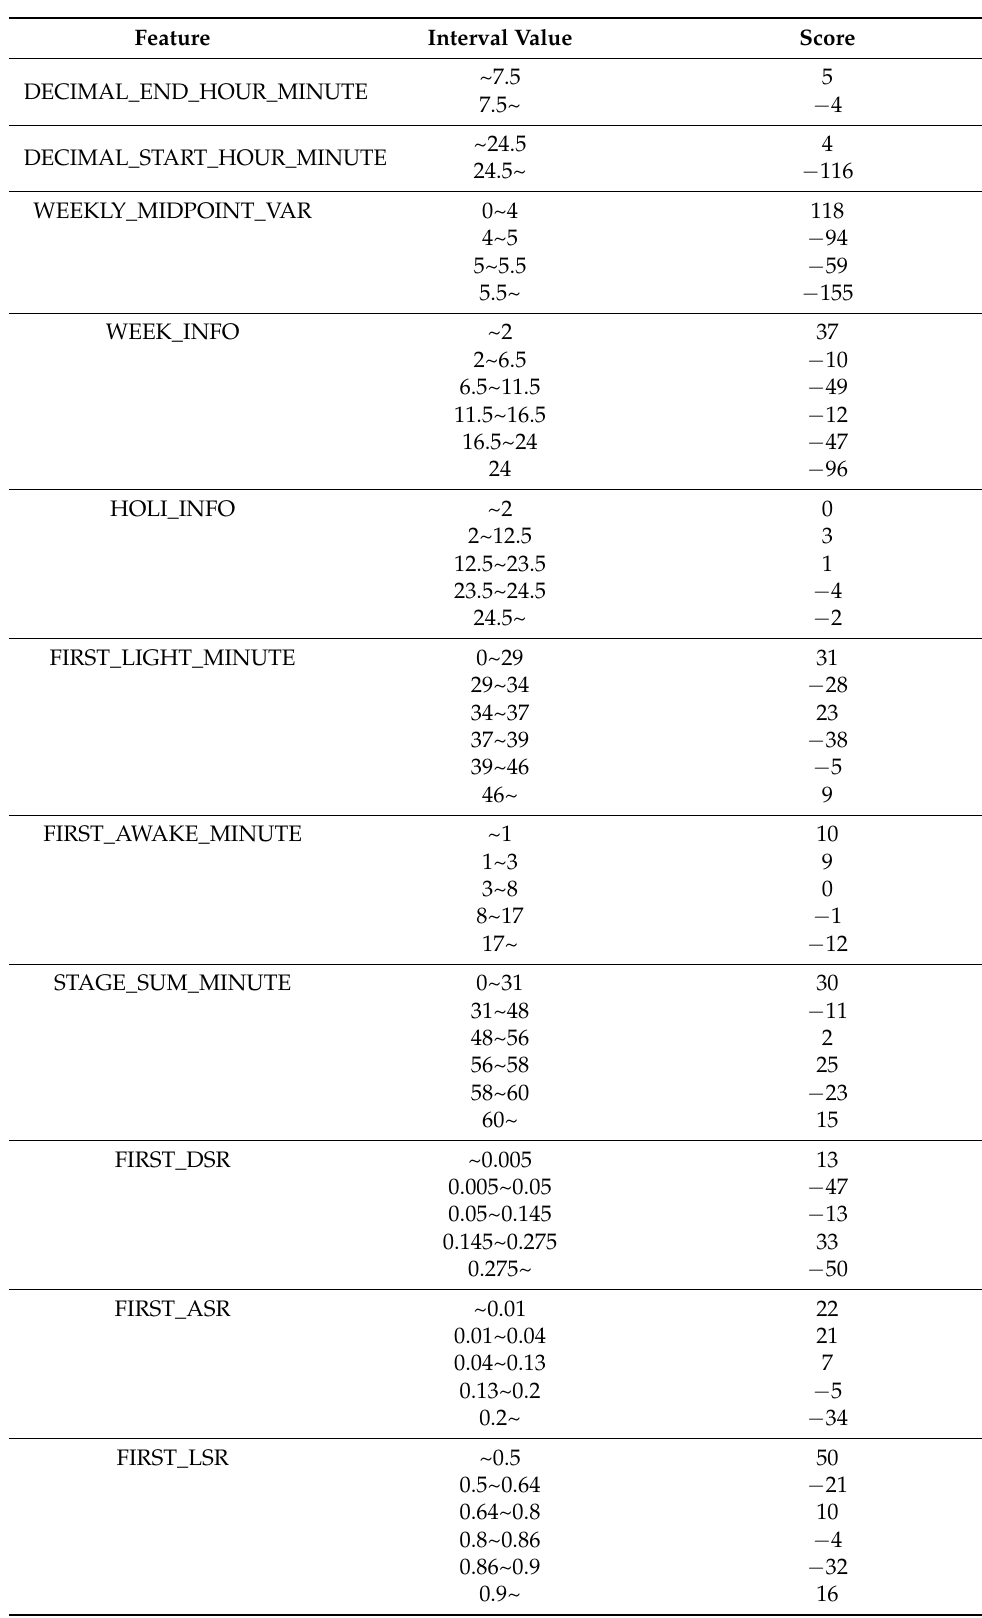
Table A2. Scorecard for each